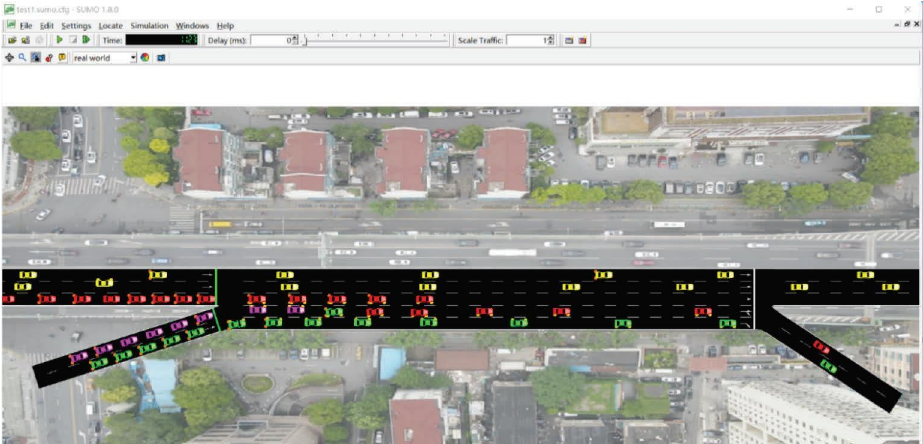
Figure 5: Actual trafc fow simulation. Table 1: Wiedemann-99 car-following model and SL2015 lane-changing model parameters.